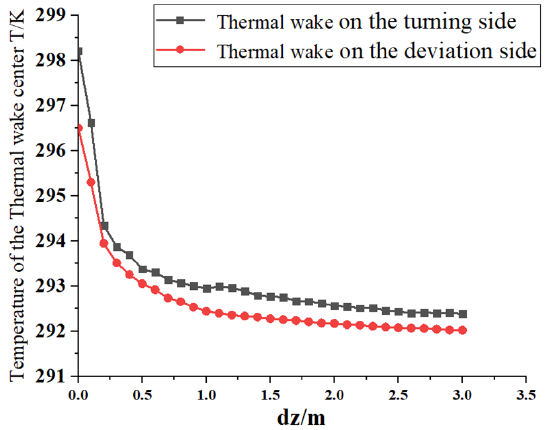
Figure 16. Variation of center temperature of thermal wake with distance DZ away from the rear body.